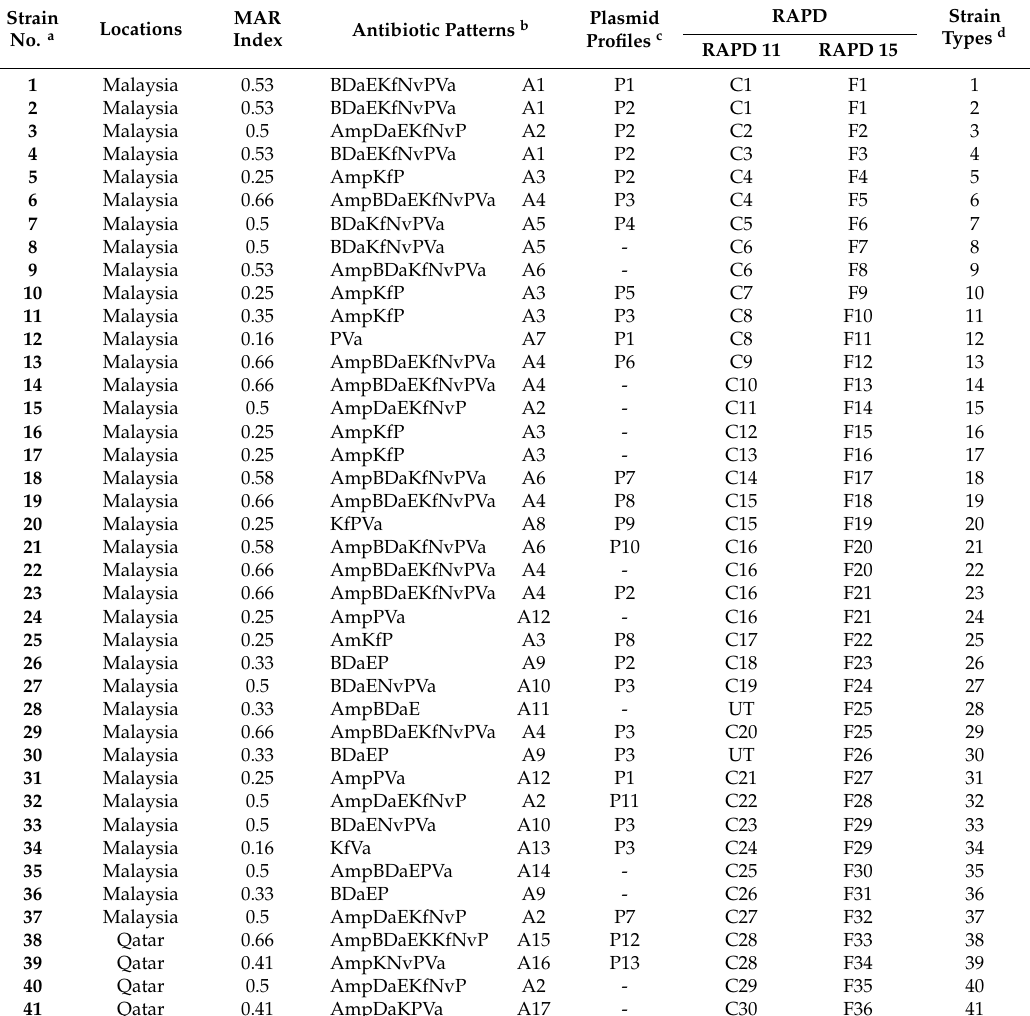
Table 2. Multiple antibiotic resistance (MAR), antibiotic resistance, plasmid profiling, and random amplified polymorphic DNA (RAPD) analysis of Vibrio vulnificus isolated from cockles ( Anadara granosa ) from Malaysia and clams ( Mercenaria mercenaria ) from